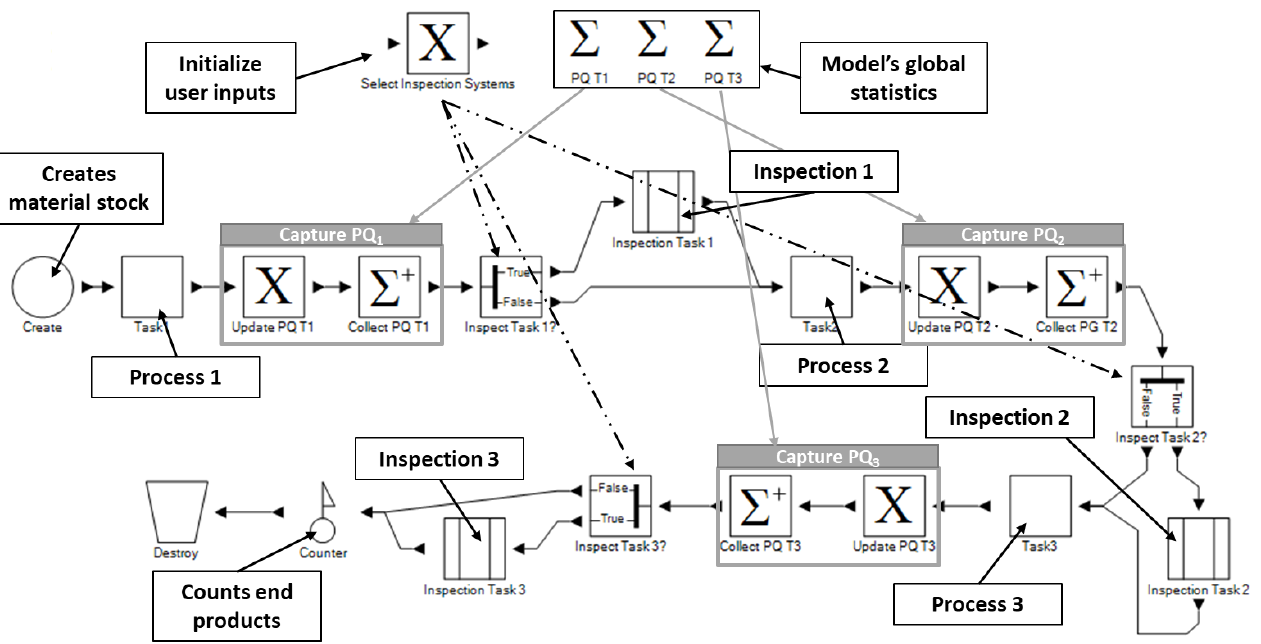
Figure 5. Overview of the discrete-event model used as case study (in Simphony).